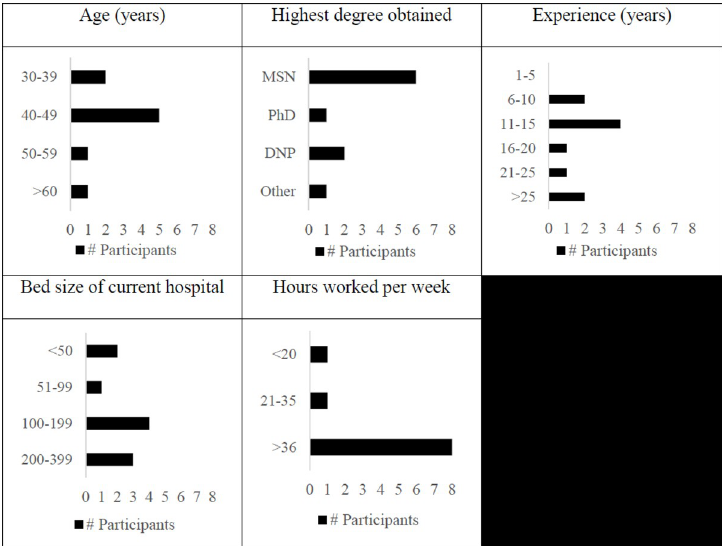
Fig 1. Demographic information collected from participants (note that one participant did not provide age).